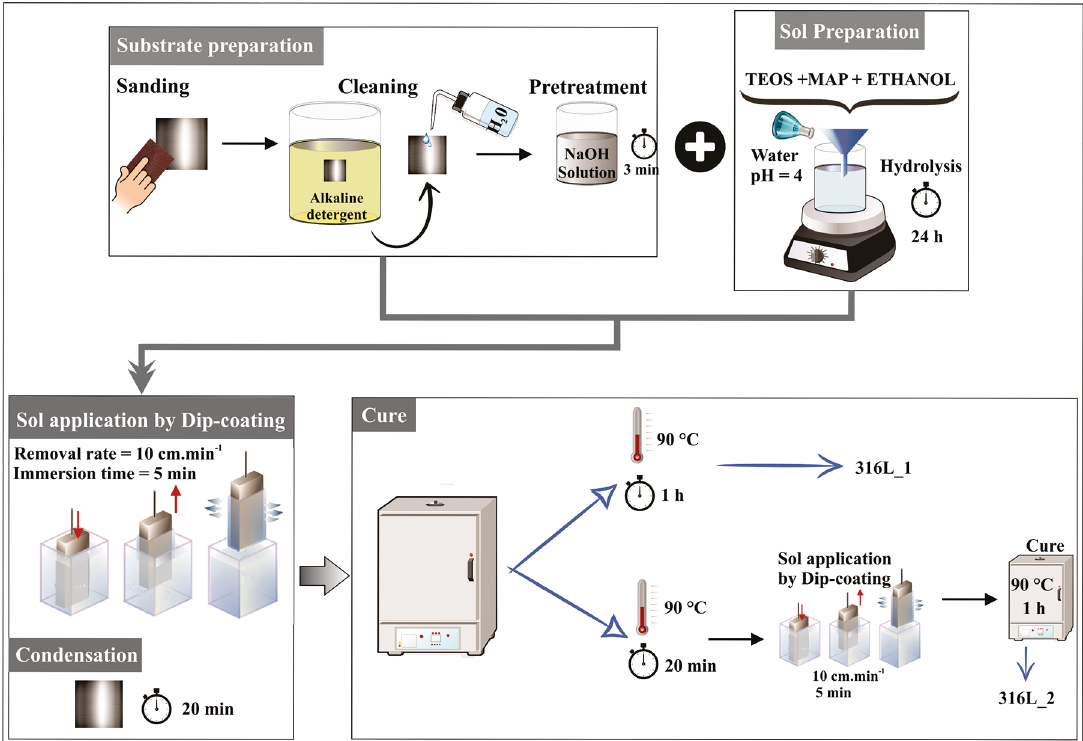
Figure 1. Flowchart with experimental parameters for sol synthesis and procedures for coating deposition in the